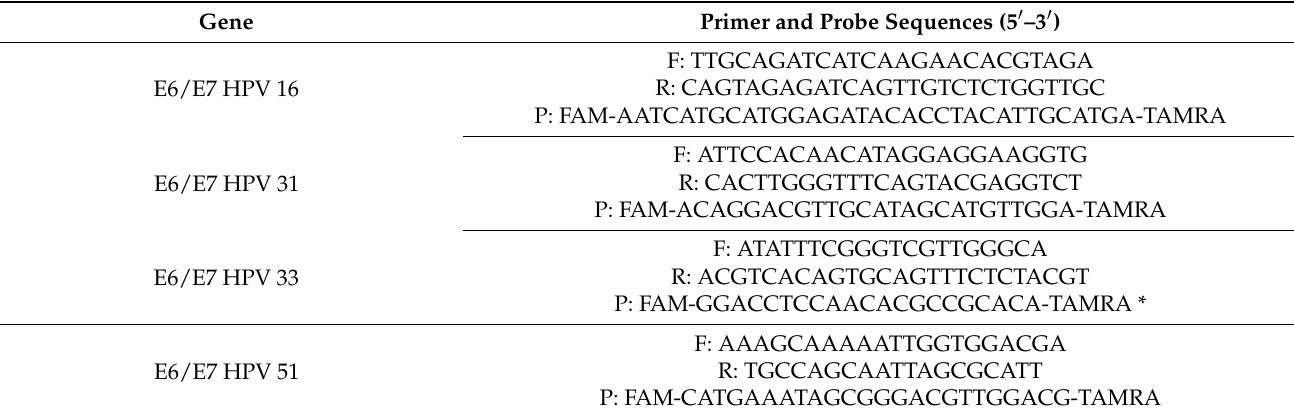
Table 1. Primer and probe sequences used for the RT-PCR